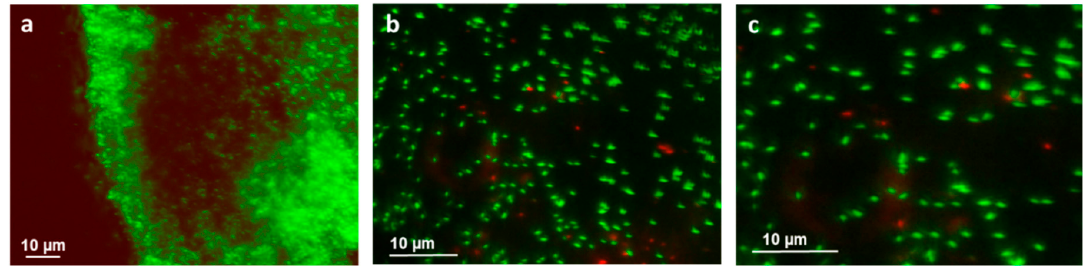
Figure 6. Fluorescence microscopy images of S. aureus on the surfaces of Nylon 6 ( a ); Nylon 6-NH ( b ) and Nylon 6-N-PEG ( c ). Figure 7. Fluorescence microscopy images of P. aeruginosa on the surfaces of ( a ) Nylon 6; ( b ) Nylon 6- Figure 7. Fluorescence microscopy images of P. aeruginosa on the surfaces of Nylon 6 ( a ); Nylon 6-NH ( b ) NH and ( c ) Nylon 6-N-PEG. and Nylon 6-N-PEG ( c